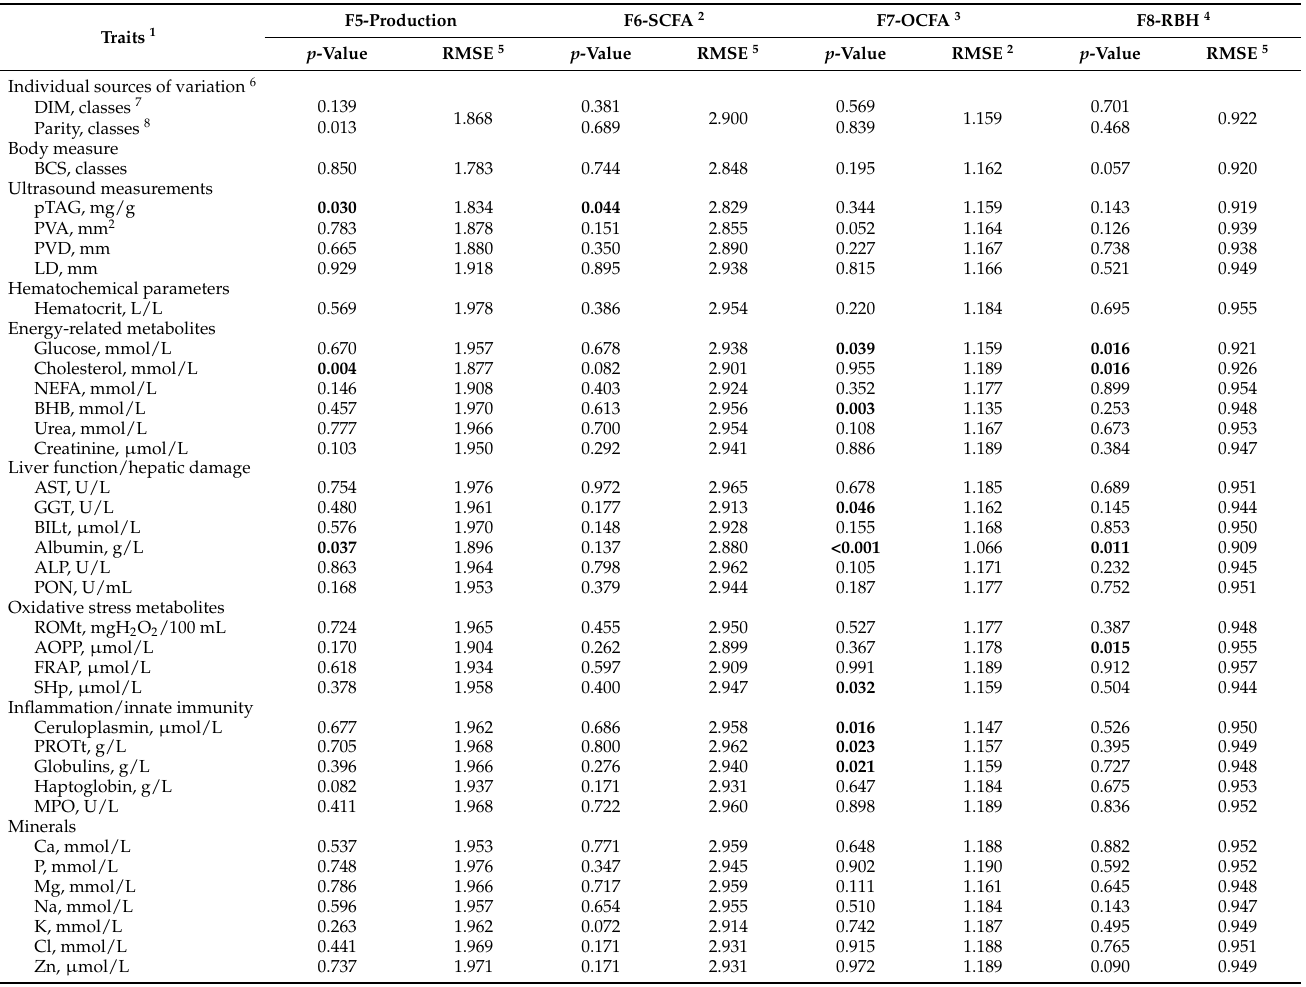
Table 4. Results from linear mixed model ( p -values) for the extracted factors F5, F6, F7, and